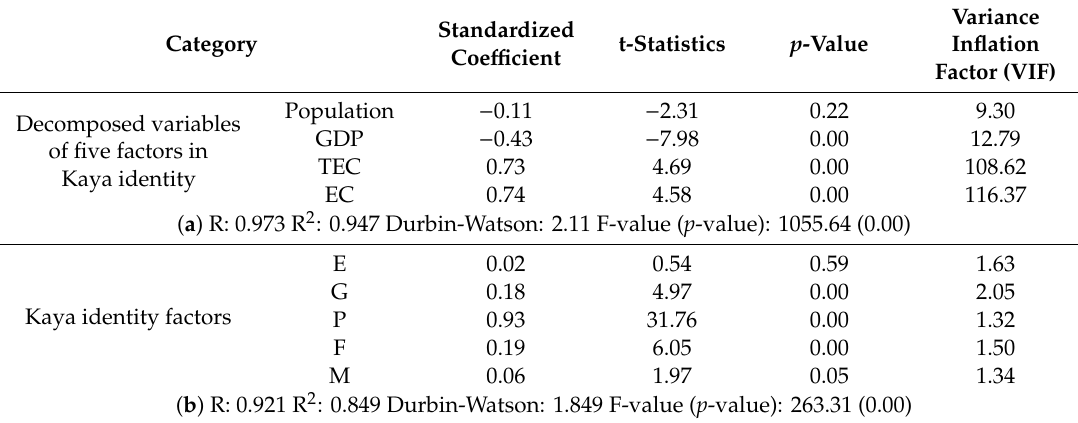
Table 2. Results of the multivariate linear regression of ( a ) decomposed variables on F Foss and ( b ) Kaya identity factors on F Foss .